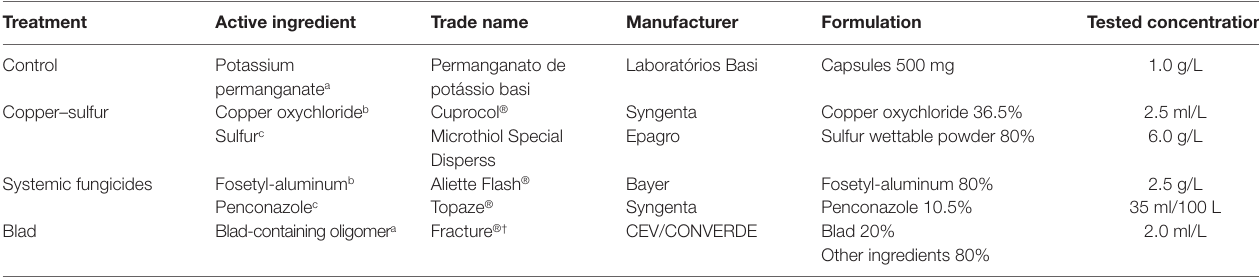
TABLE 1 | Chemical treatments sprayed fortnightly on grapevine rooted cuttings. Six applications were performed during 3 months. Each active ingredient was sprayed separately.